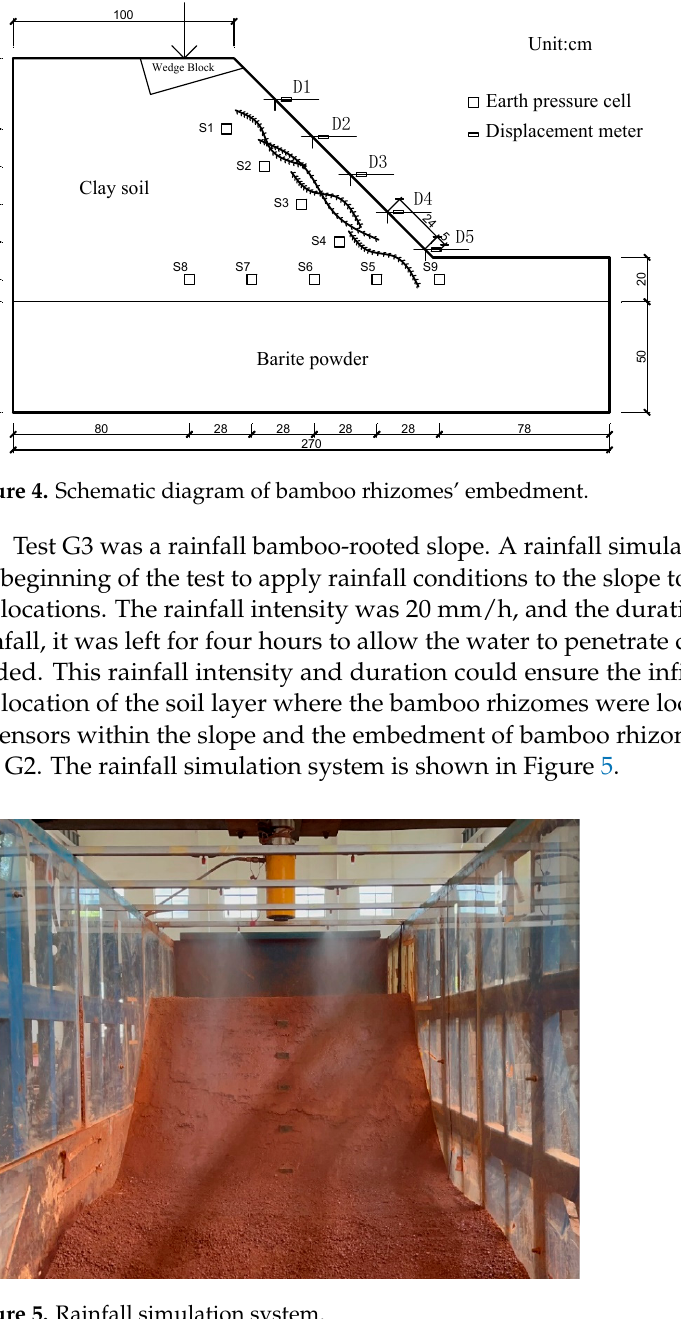
Figure 5. Rainfall simulation